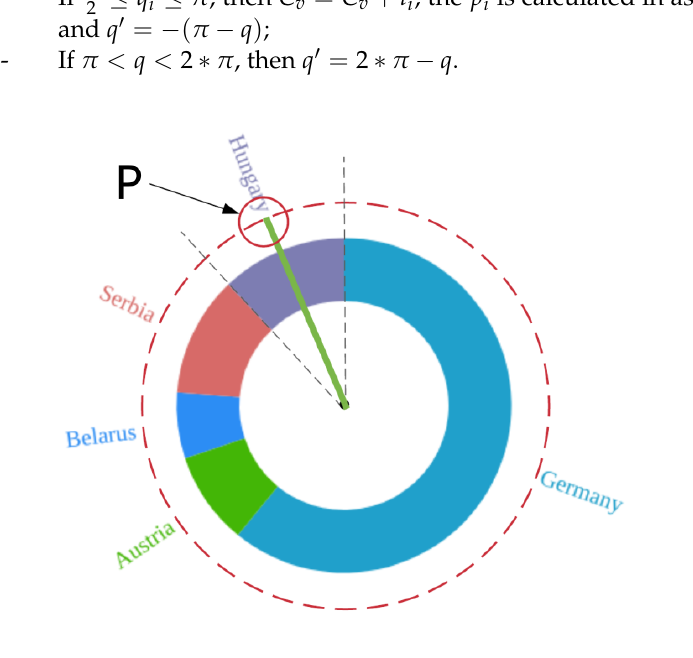
Figure 3. Angle label arrangement.